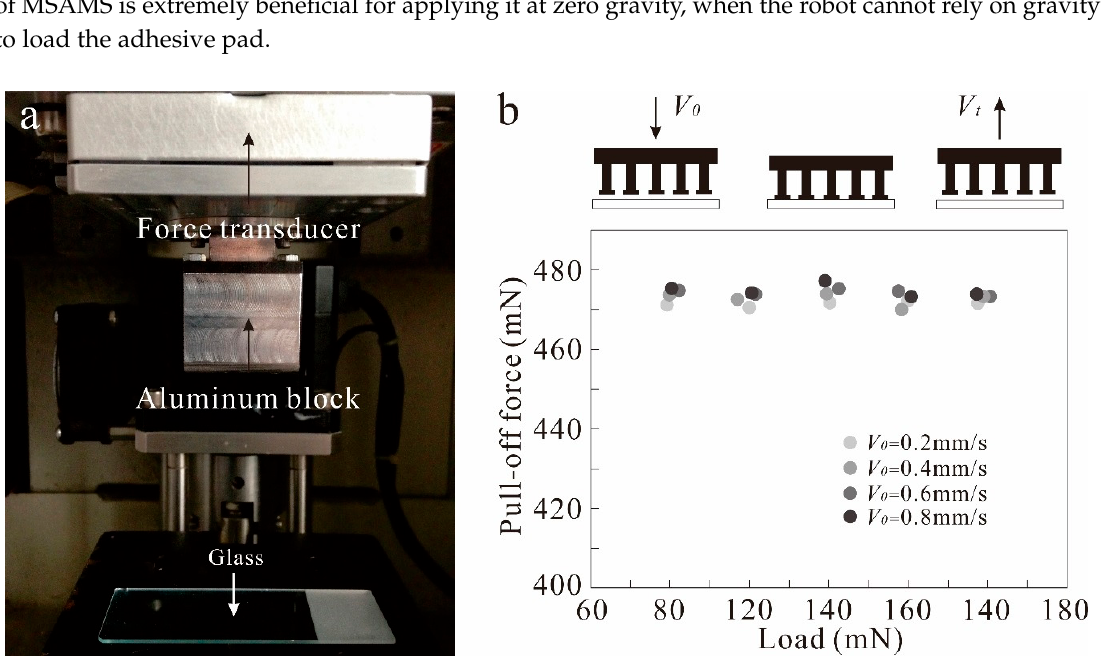
Figure 3. ( a ) Image of the setup used to measure the pull-off force; ( b ) The pull-off force measured between mushroom-shaped adhesive microstructure (MSAMS) and glass as a function of load at different load velocities.